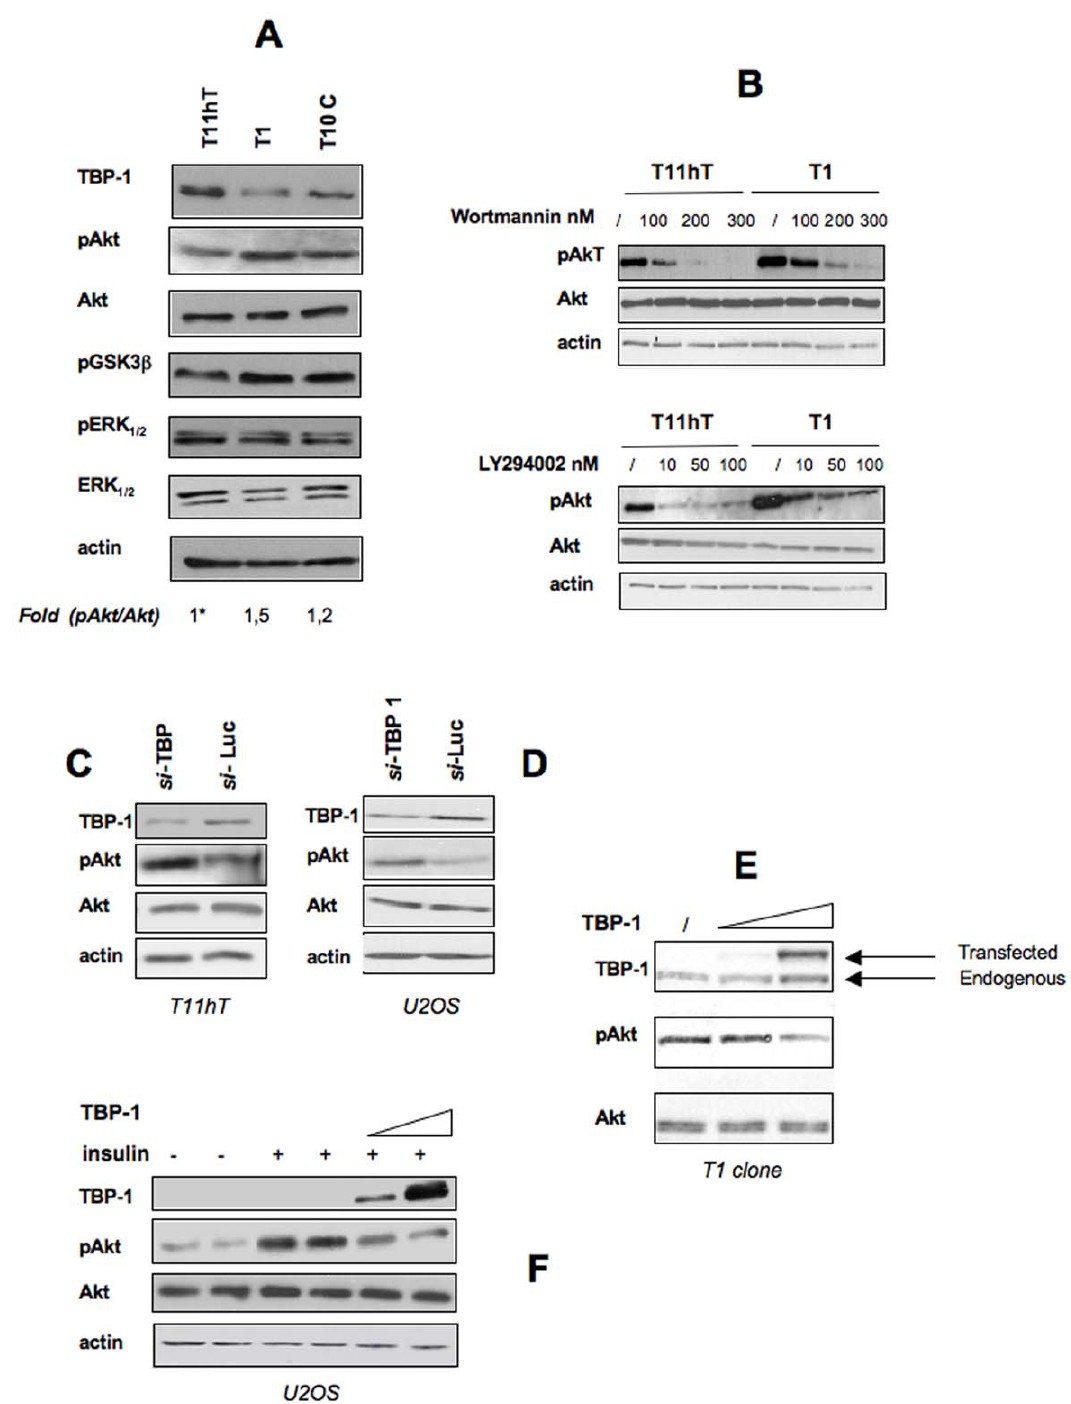
Figure 5. TBP-1 knockdown determines activation of the Akt/PKB kinase. A: Cells from the T1, T10C and control cells (wt T11hT) were cultured in DMEM + 10%FBS for 24 hrs. Activation of Akt/PKB was revealed by Western Blot with anti-Phospho-Akt Ser473 antibody. As control, extracts were also probed with anti-Akt, anti-Phospho-GSK-3 b /pSer219, anti-pERK 1/2 , anti-ERK 1/2 and anti-actin antibodies. Bands Intensity was measured by ImageQuant analysis on at least two different expositions to assure the linearity of each acquisition, each normalised for the respective actin values. Asterisk, fold value is expressed relative to the reference point, arbitrarily set to 1. Representative of at least four independent experiments. B: Cells from the T1 clone or control cells (wt T11hT) were plated at the cell density of 2.5 6 10 5 in DMEM + 10%FBS in six wells. After 24 hrs, either DMSO (/) or with Wortmannin or LY294002, where indicated, were added to the cells at the concentrations indicated and left for either 1 hour (with Wortmannin) or 15 9 (with LY294002). Extracts were then probed in Western Blot with antibodies against Akt, Phospho-Akt Ser473 and actin. C, D: T11hT cells ( C ) or U2OS cells ( D ) were transfected with an si RNA directed against TBP-1 or Luciferase. Extracts were probed with antibodies against Phospho-Akt Ser473, Akt and actin. E: Cells from the T1 clone were transfected with empty vector (first lane) or increasing amounts of TBP-1 expression plasmid. Activation of Akt/PKB was evaluated by Western Blot on whole protein lysates probed with anti-Phospho-Akt